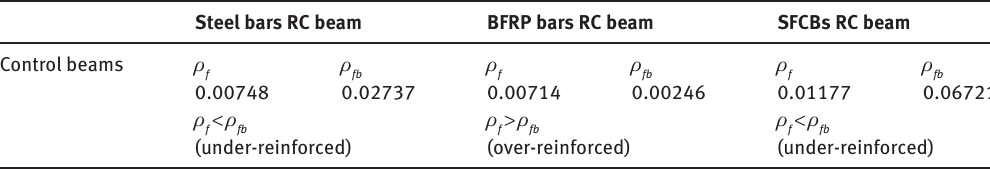
Table 3: The relationship between reinforcement ratios and balanced reinforcement